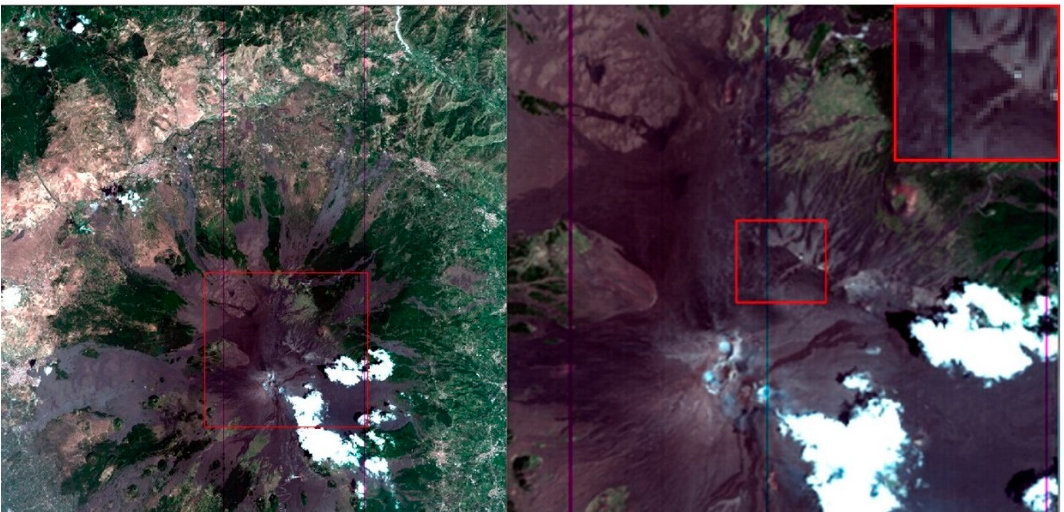
Figure 1. RGB (Red Green Blue) image of Mt. Etna and zoom on Piano delle Concazze (PdC) by PRecursore IperSpettrale della Missione Applicativa (PRISMA) acquisition on 31 July 2019.